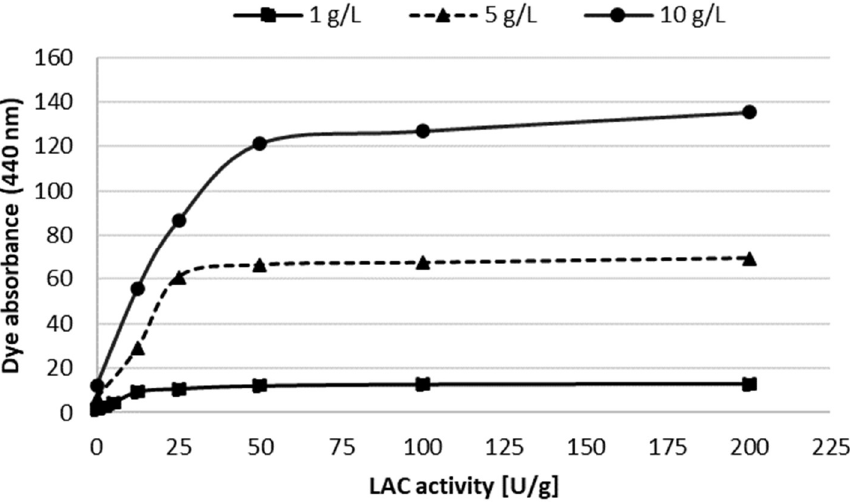
Figure 3. Effect of LAC activity (2.5–200 U/g: U per gram of ANS) on the absorbance of the dye obtained after the 24 h LAC-mediated oxidation of ANS different concentrations (1, 5 and 10 g/L) in a buffered transformation mixture containing 5% v / v methanol as a co-solvent. Table 2. Environmental toxicity of the ANS substrate and the dye after 5 min of exposure on V. fisheri bacteria, expressed as half maximal effective concentration (EC 50 ) according to the 81.9% Basic Test Microtox protocol.